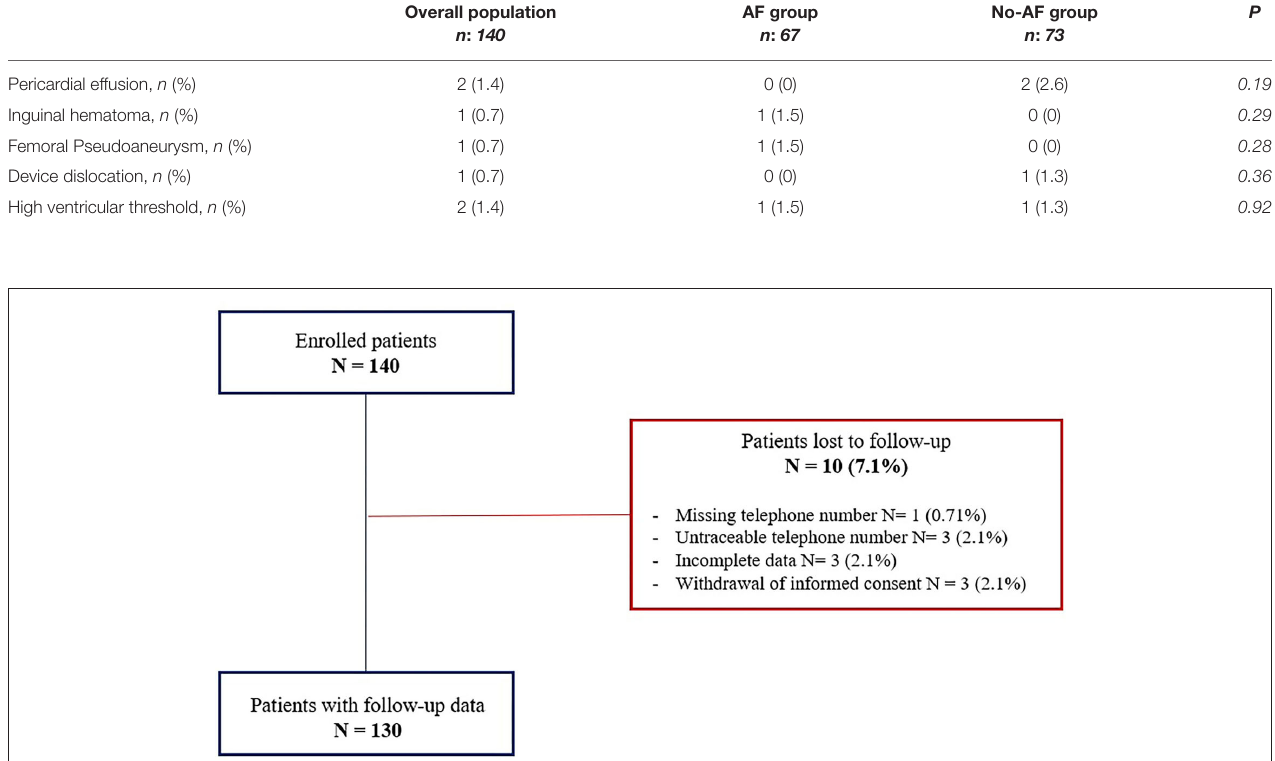
TABLE 3 | Perioperative complications.